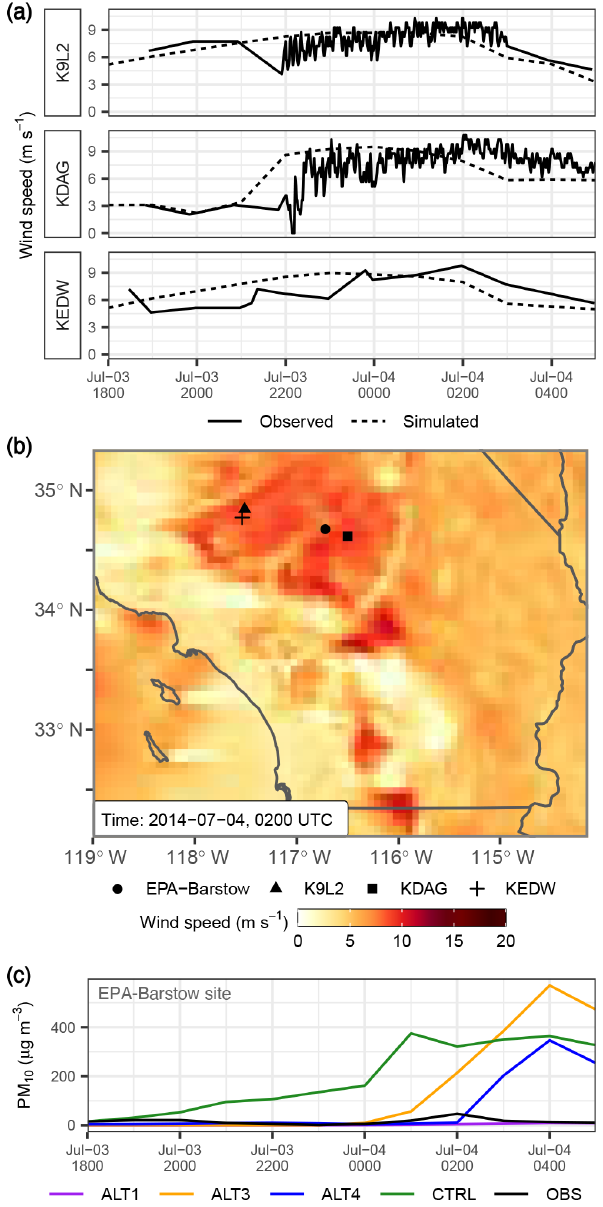
Figure 14. Simulated and observed (a) surface wind speed and (c) PM 10 values for ASOS and EPA station locations in the Mojave Desert area associated with the erroneously simulated PM 10 plume. The spatial plot (b) shows the station locations relative to the area of maximum wind speed simulated by the model over the Mojave Desert on 4 July 2014 at 02:00UTC, when observed PM 10 values for the general location